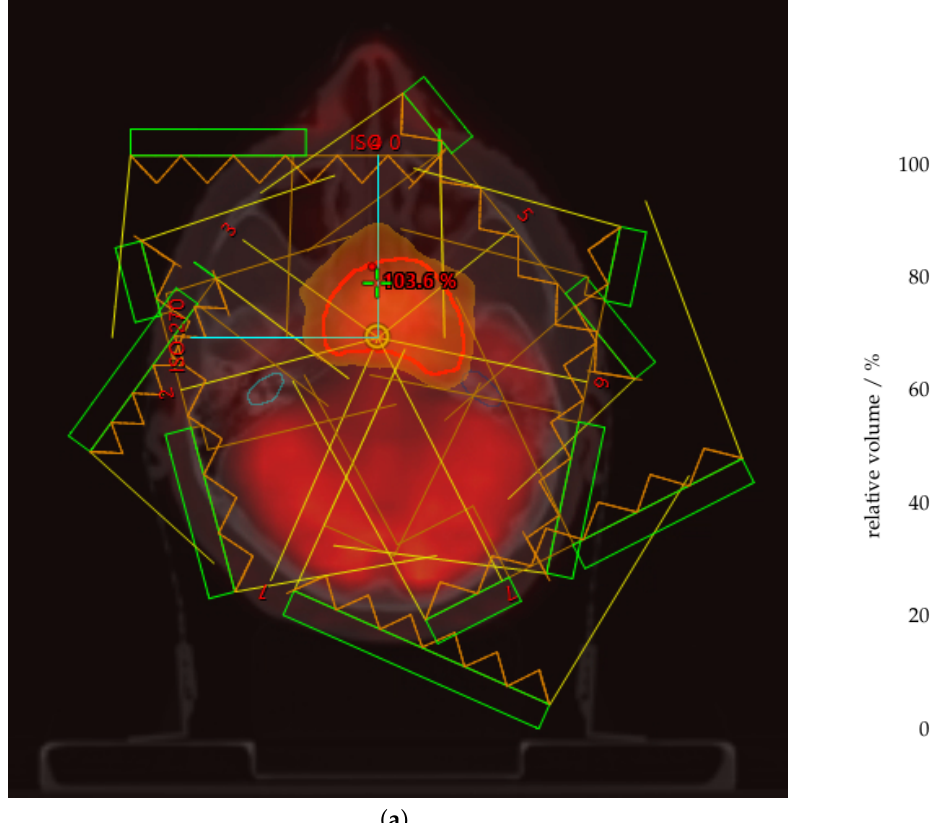
Figure 6. Dose distribution and dose volume histogram of definitive radiochemotherapy of nasopharyngeal cancer with clivus infiltration. ( a ) Tumor in the left paramedian nasopharynx, exceeding the midline, with high glucose metabolism, SUV max 16.5 and arrosion of the clivus on the left side adjacent to the left inner ear. 95% Isodose of the radiotherapy plan with protection of the inner ears using intensity modulated radiotherapy in 7-field sliding-window technique. Nevertheless, especially the left inner ear is exposed to high doses and unfortunately grade 3 hearing impairment occurred. ( b ) Corresponding cumulative dose-volume histogram: PTV1: Bilateral regional lymphatic drainage pathways and nasopharyngeal area with 50.4 Gy PTV2: Affected lymphatic drainage pathways and primary tumor with 59.4 Gy PTV3: Nasopharynx tumor and the affected lymph nodes on both sides with 72.0 Gy Right inner ear: Dmax 33.6; Dmean 20.8 Gy Left inner ear: Dmax 70.5 Gy; Dmean 39.9